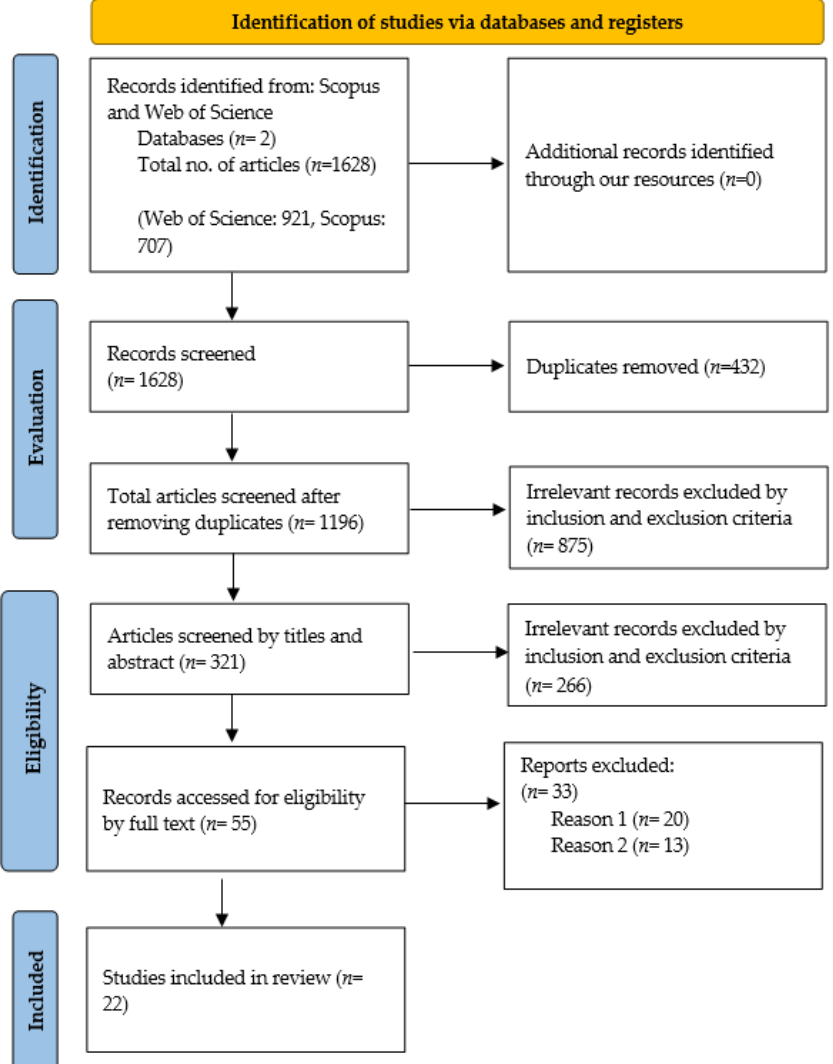
Figure 2. PRISMA flow diagram illustrating the stages in the systematic review.